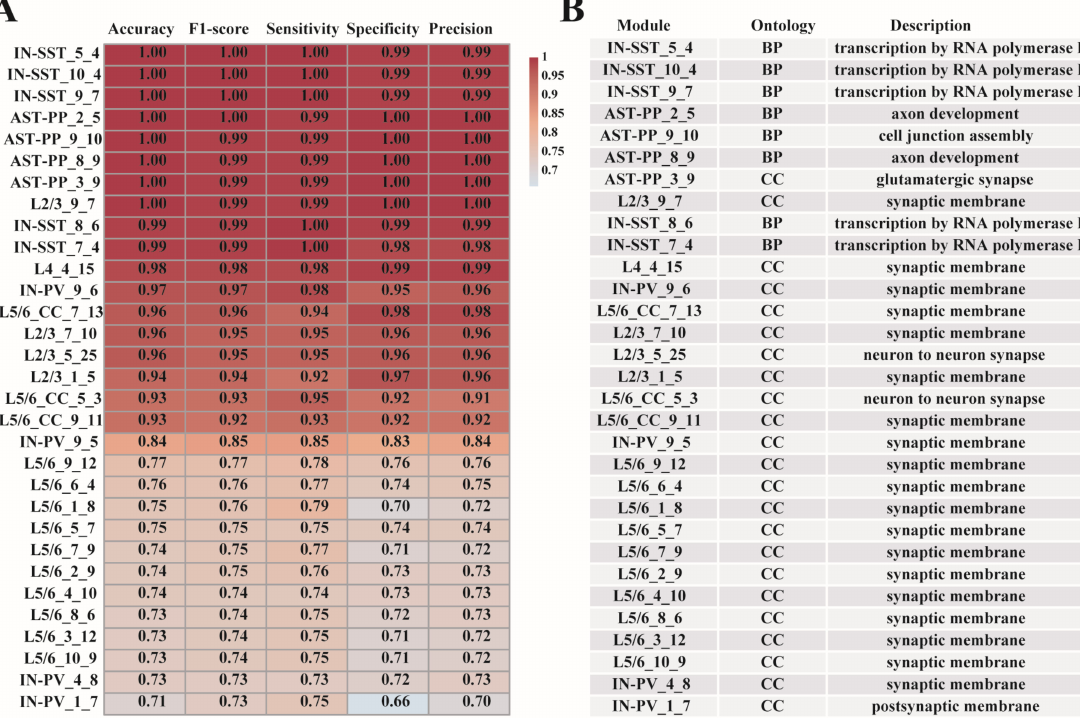
Figure 5. ( A ) The predictive performance and ( B ) the top one enriched GO functions of the final 31 cell-type-specific ASD-associated gene